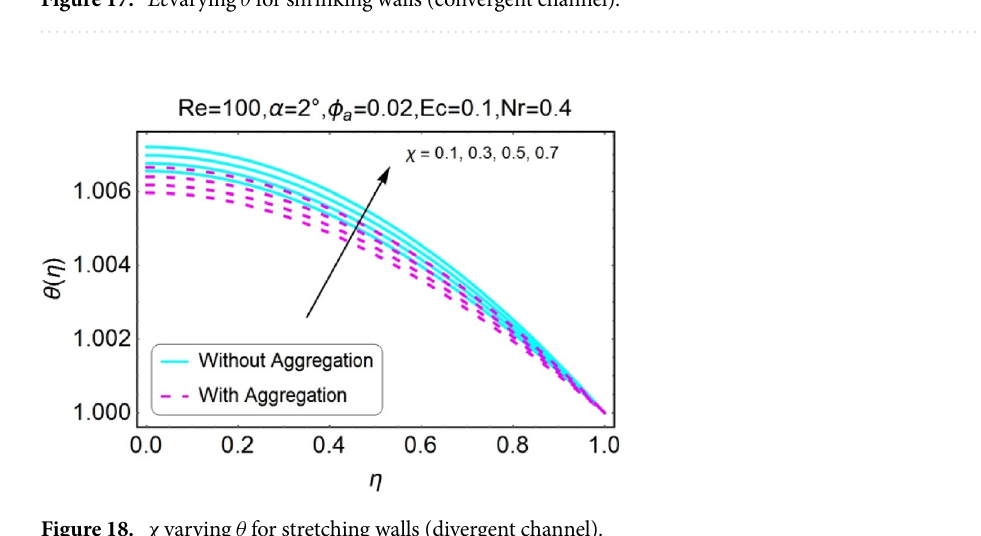
Figure 17. Ec varying θ for shrinking walls (convergent channel).